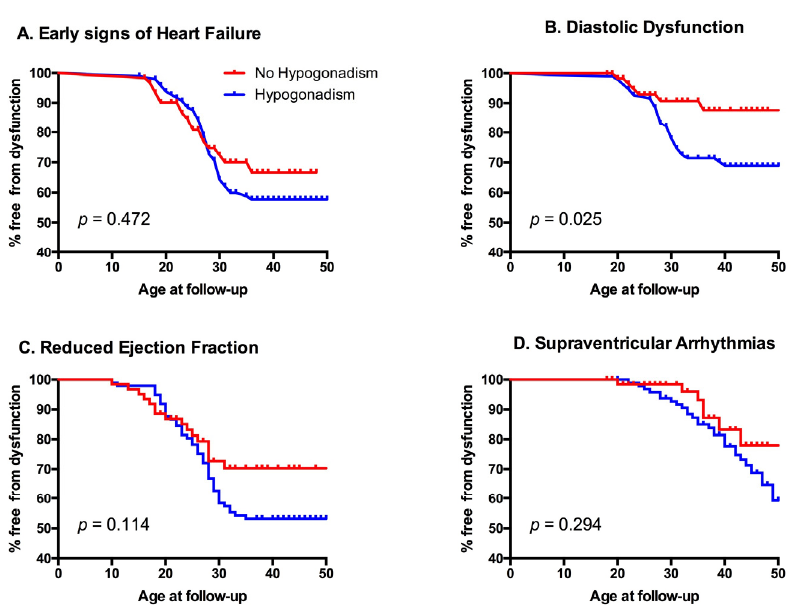
Table 5. Cardiovascular outcomes distribution.